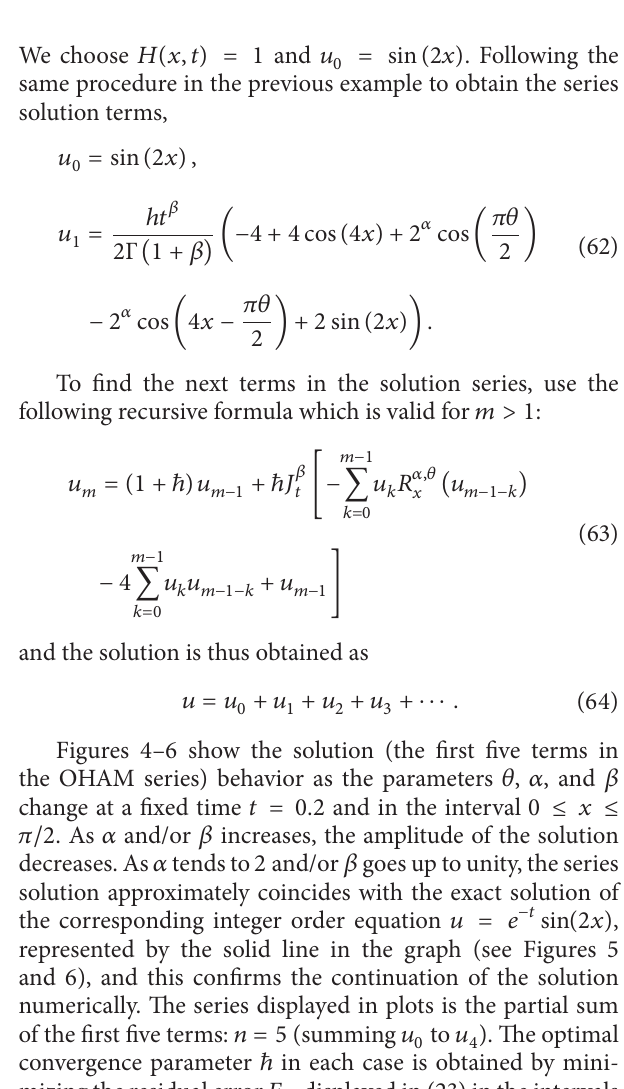
Figure 4: The behavior of the four terms of OHAM solution of (57) at 𝑡 = 0.2 , 0 < 𝑥 < 𝜋/2 , and the fractional parameters 𝛼 = 1.5 and 𝛽 = 1 and the skewness 𝜃 = 0, 0.5, −0.5